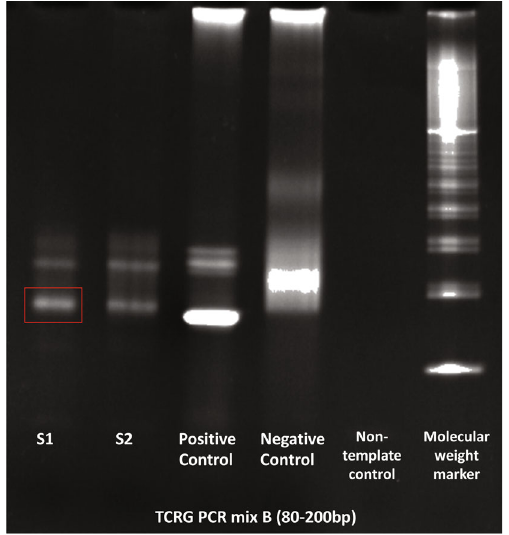
Figure 4: Gel electrophoresis showing clonal band for T-cell receptor gamma. The tumor is shown in the S1